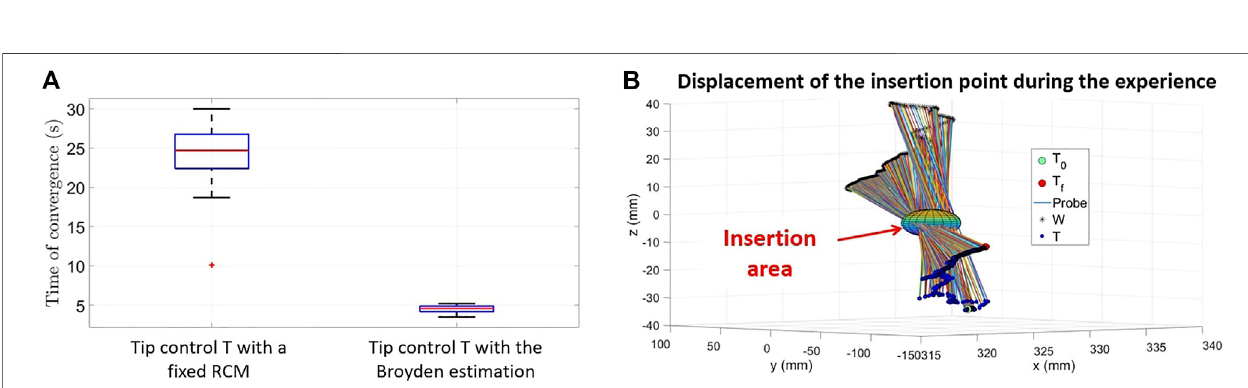
Frontiers in Robotics and AI |